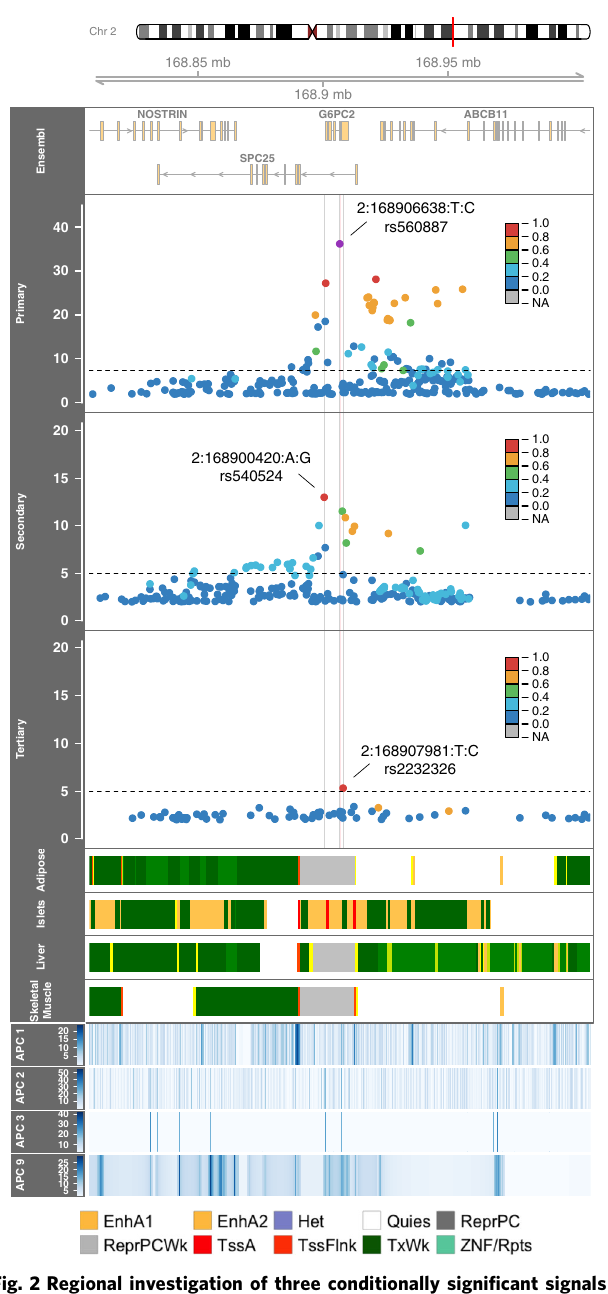
Fig. 2 Regional investigation of three conditionally signi fi cant signals associated with fasting glucose in the G6PC2 locus in TOPMed. Regional association plot of − log10 P values by genomic position for sequential conditional single-variant analyses. The linkage disequilibrium ( r 2 ) between the primary signal (rs560887, 2:168906638:T:C), as de fi ned by the highest posterior probability, and variants in the region for each panel as calculated in TOPMed is indicated in the colors of the points. The chromatin states at four relevant tissues 47 and annotation PCs are provided across the region. APC1, APC Epigenetics, APC2, APC Conservation, APC3, APC Protein, APC9, APC Distance to TSS/TSE; EnhA1, Active Enhancer 1; EnhA2, Active Enhancer 2; Het, Heterochromatin; Quies, Quiescent/Low; ReprPC, Repressed PolyComb; ReprPCWk, Weak Repressed PolyComb; TssA, Active TSS; TssFlnk, Flanking TSS; TxWk, Weak Transcription; ZNF/Rpts, ZNF genes & repeat.